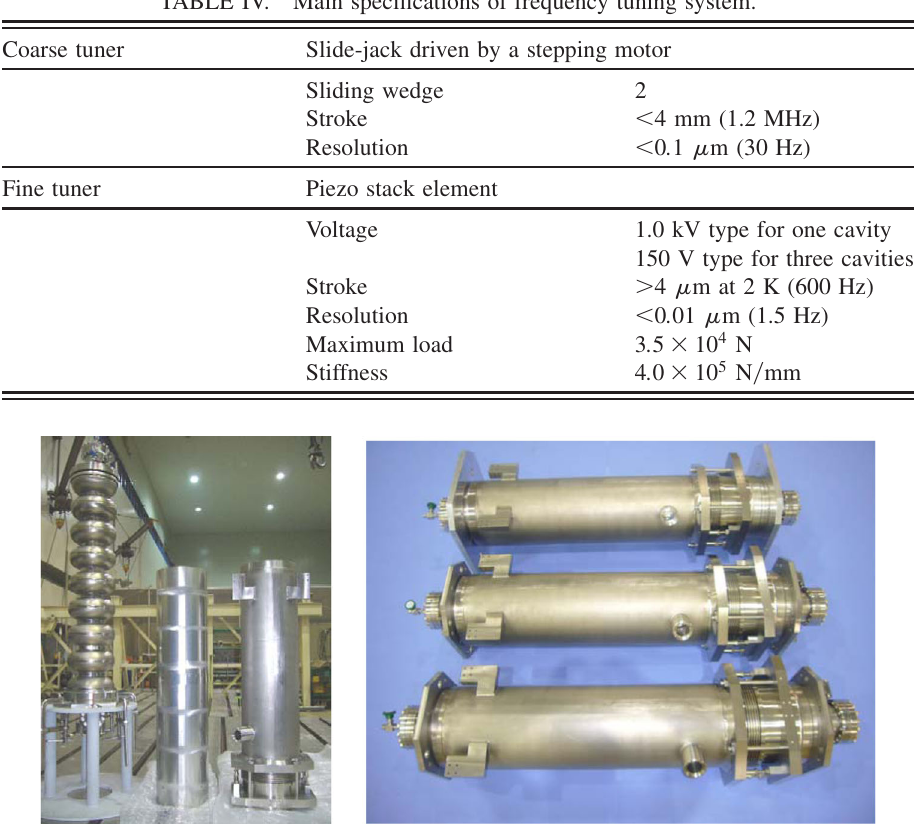
FIG. 6. (Color) Tesla-like nine-cell cavity, magnetic shield, and titanium helium vessel (left). Three completed cavities after welding of helium jacket (right).